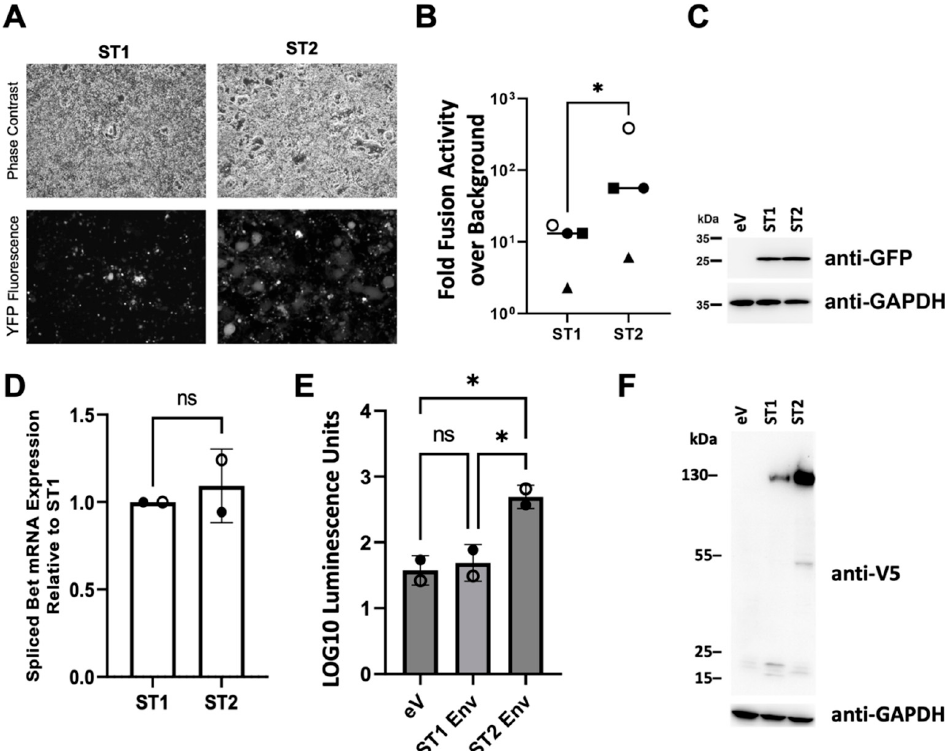
Figure 3. The R289hybAGM-derived env gene effects increased cell-cell fusion in the same genetic